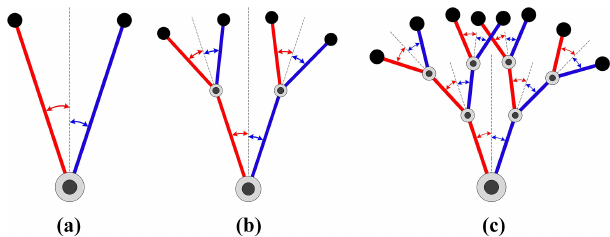
Figure 1. Joint perturbation combinations of manipulator with n DOFs. (a) n = 1. (b) n = 2. (c) n =